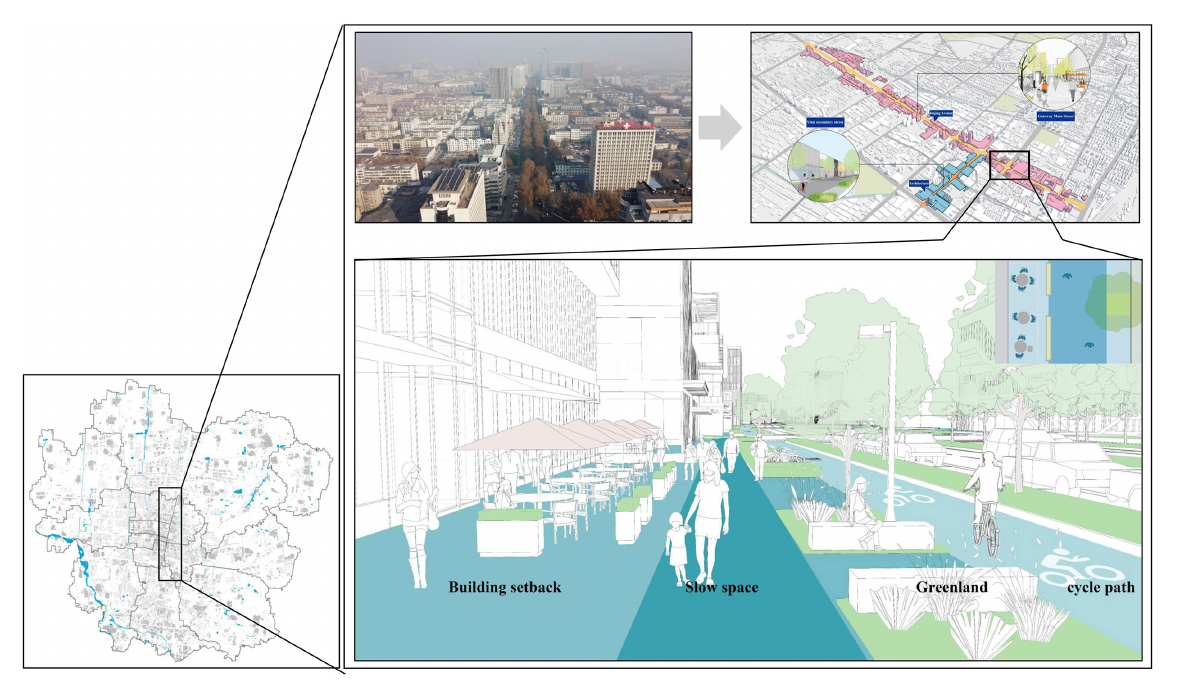
FIGURE11 Low-carbon and health-oriented Jinjing Avenue design